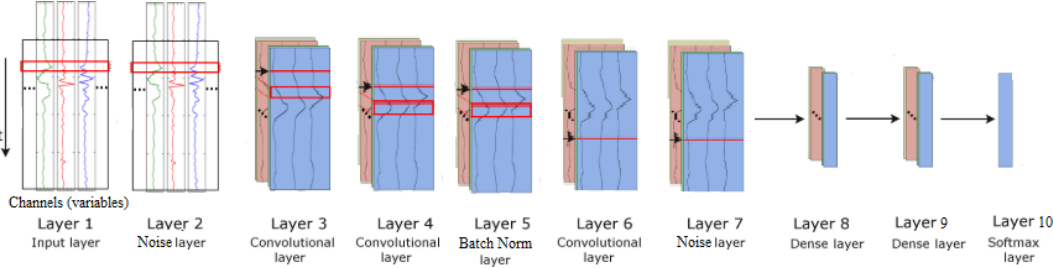
Figure 9. Architecture of the CNN model for ice-jam prediction (adapted after Ordóñez and Roggen, 2016).